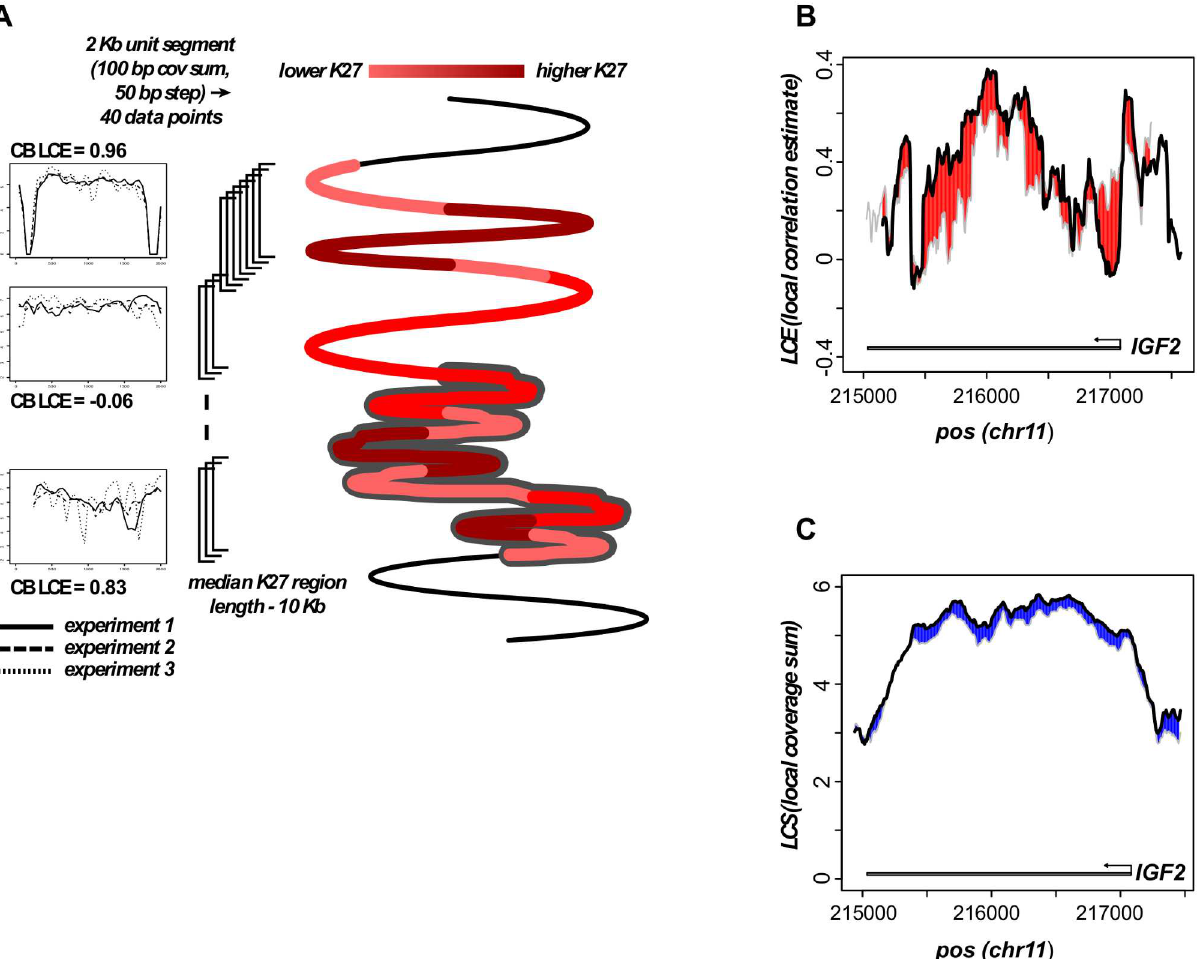
Fig 9. Schematic explanation of local correlation estimate (LCE) parameter. A. Inset panels at left show arbitrarily selected 2 kb segments from cord blood (Cb) monocyte data intended to be representative of the full range of LCE values. B. Example showing young and old adult monocyte LCE region profiles for the IGF2-associated PcG region. C. Example showing young and old adult monocyte local coverage sum (LCS) region profiles for the IGF2-associated PcG region.